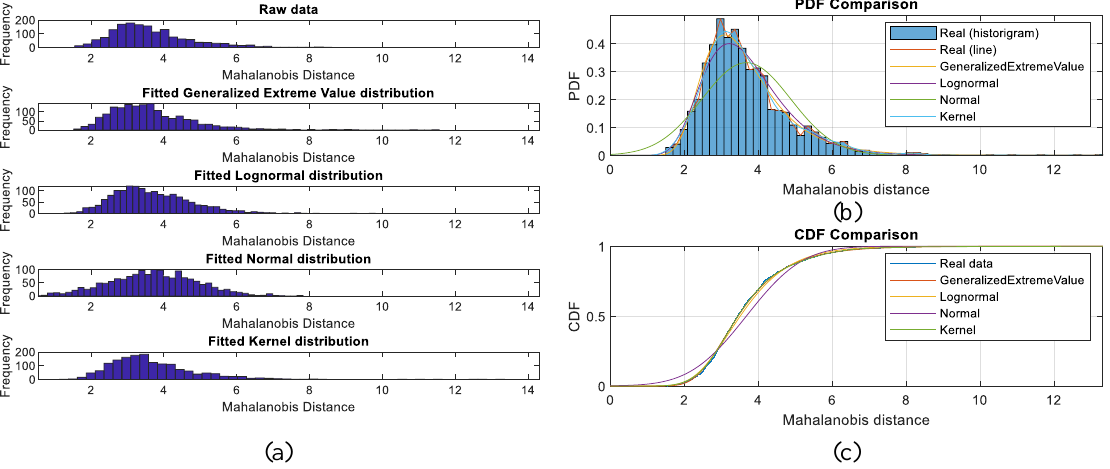
Table 3. Results of K–S test for case one.